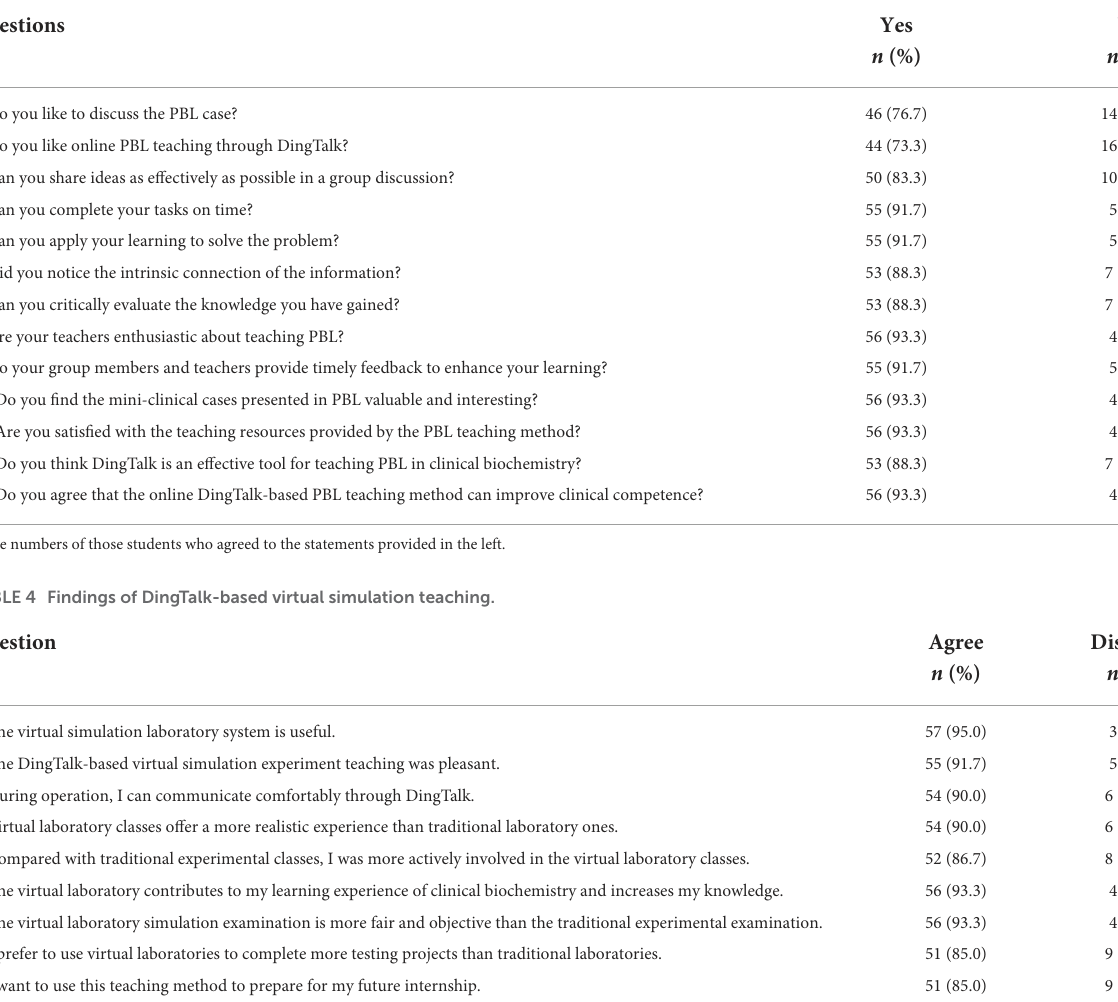
TABLE 3 Questionnaire survey results of the DingTalk-based PBL teaching method.